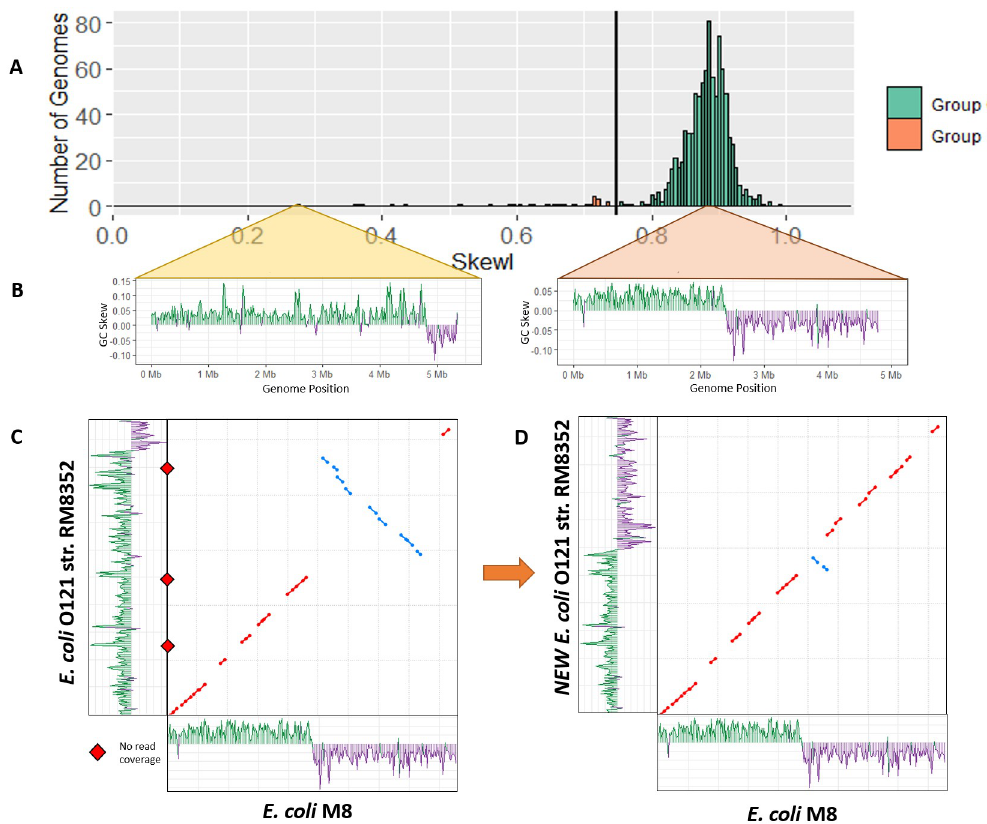
Fig 3. Escherichia skew index values. A) SkewI for all 934 Escherichia genomes. The threshold (vertical black line) is at 0.749. B) GC-skew plots for Escherichia coli O121 strain RM8352 and Escherichia coli M8 . E. coli O121 has an unusually low SkewI of 0.275, while E. coli M8 has a SkewI of 0.877, which is typical for this genus. C) Initial alignment between the two E. coli genomes revealed a large inversion. Alignment of the assembly reads revealed locations with no read coverage (red diamonds) E. coli O121 at both ends of the inversion. D) Flipping the inversion in strain RM8352 produced a much more consistent alignment between the E. coli genomes (dot plot), and restored the GC skew plot to a more normal appearance (shown along the y axis).